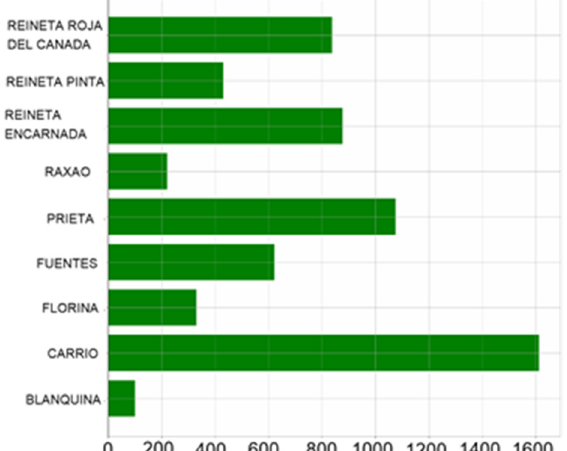
Figure 5. Number of images of each apple variety.